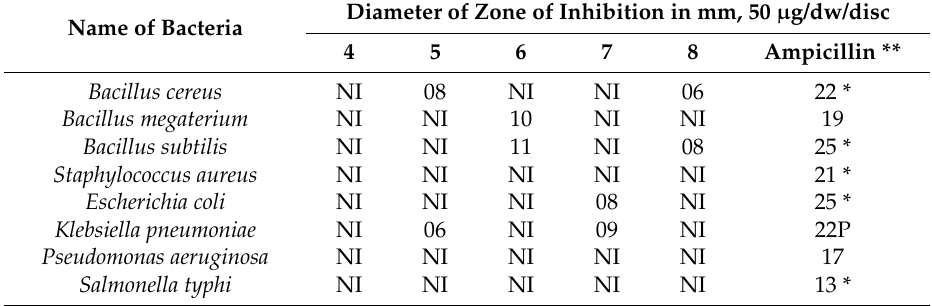
Table 3. Inhibition against bacterial organism by the rhamnopyranosides 4 – 8 .